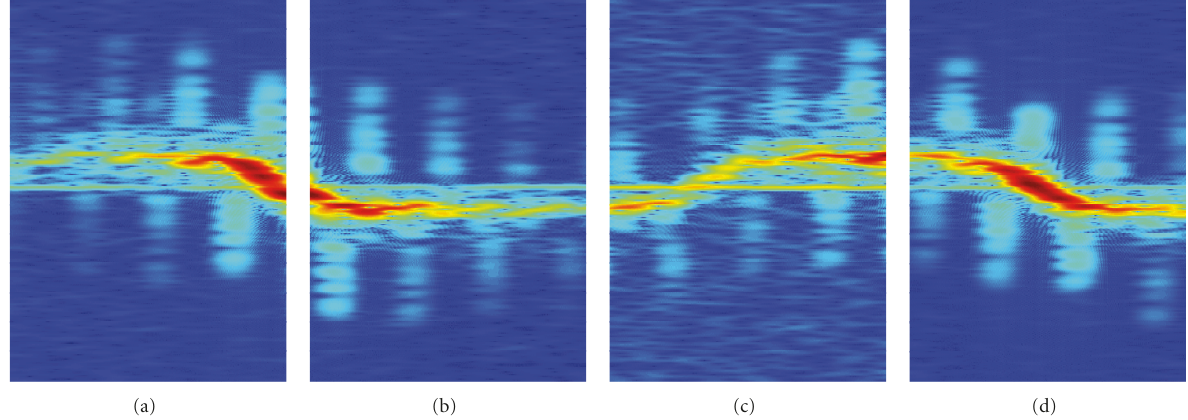
Figure 6: Four non-overlapping segments of length 4.7 seconds extracted from one-arm motion spectrogram.